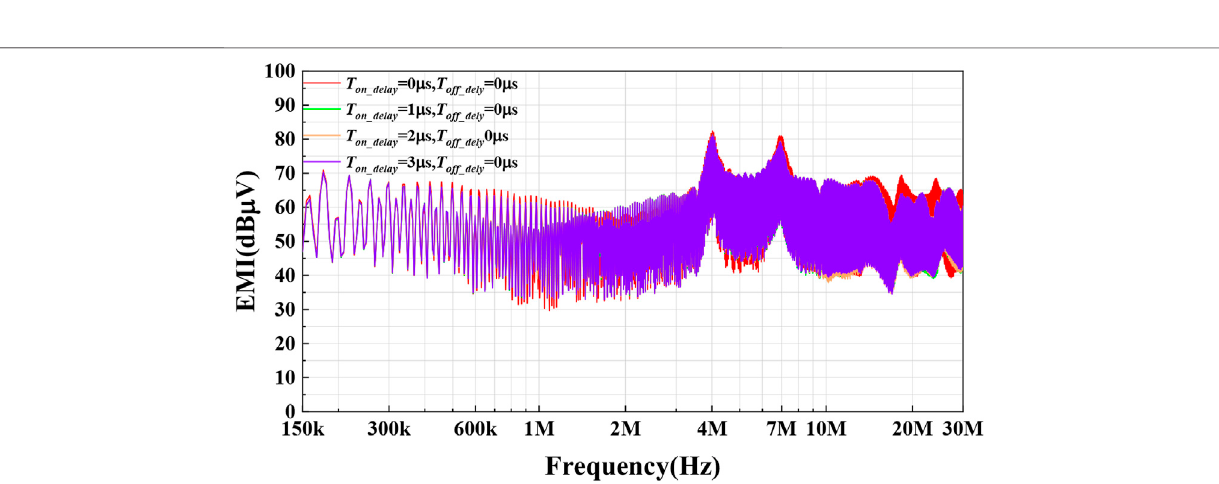
FIGURE 7 | Waveforms of CM voltage and its spectral envelope at different T on_delay (pattern 1). (A) Fall time t f and (B) spectral envelope.